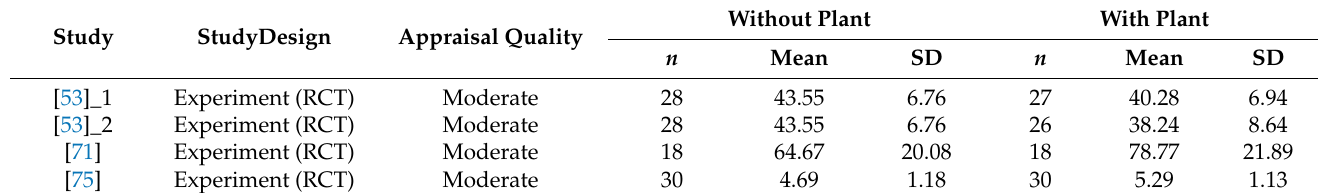
Table 14. Original data of the studies examining the influence of indoor plants on attention.